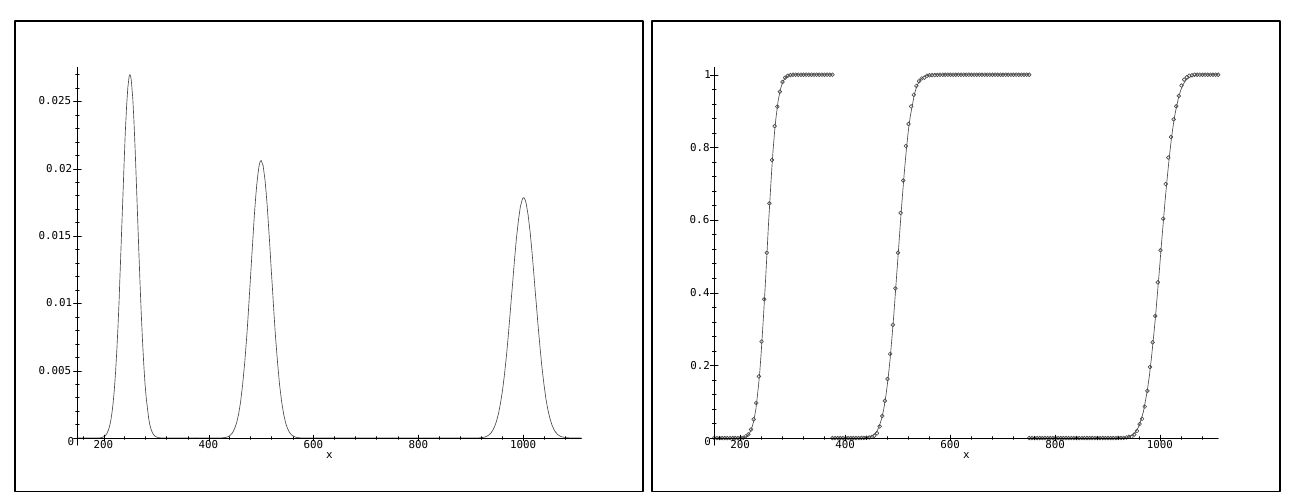
Fig. 15: Pr (cid:1) X i (cid:1) m (cid:3)(cid:0) 1 (cid:3)(cid:2) i (cid:0) 1